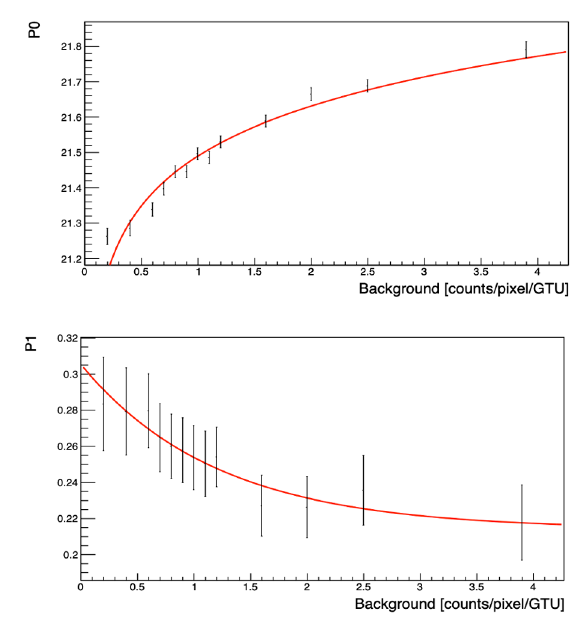
Figure 5. The dependence of the P 0 and P 1 parameters as a function of the background level is displayed. A logarithmic (for P 0 ) and an exponential function (for P 1 ) have been used to parametrize their